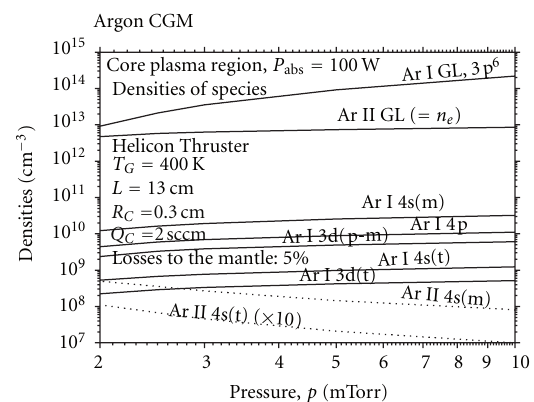
Figure 16: Calculated densities of Ar GL , Ar excited species, and Ar + versus pressure in the core plasma region of a helicon thruster.